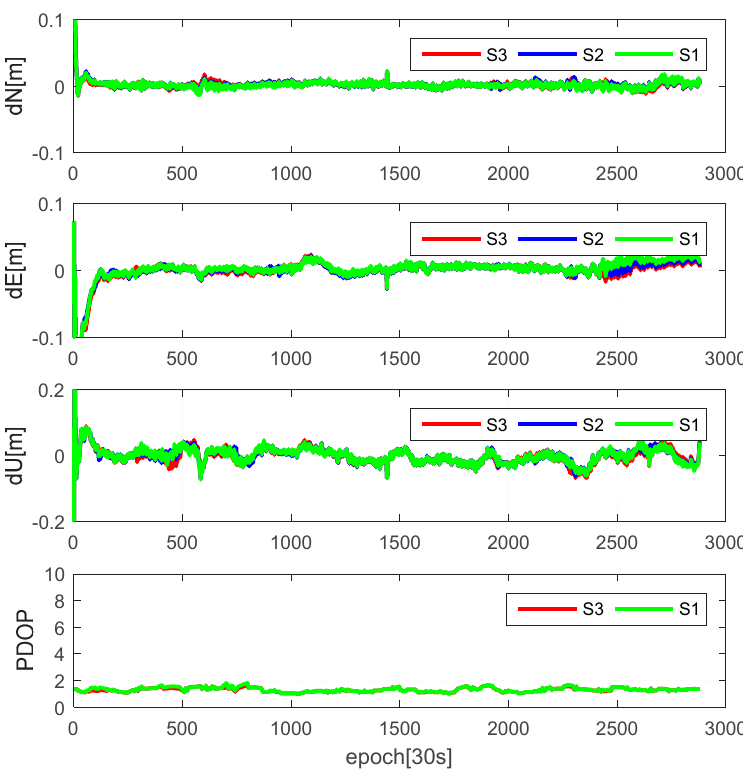
Figure 15. The positioning performance of GR kinematic PPP for three eclipsing strategies. (Station AREG, DOY 194 of 2017, the sampling rate is 30 s). Table 7. The average convergence time (minute) and the percentage of convergence under different session length (30 min and 60 min).